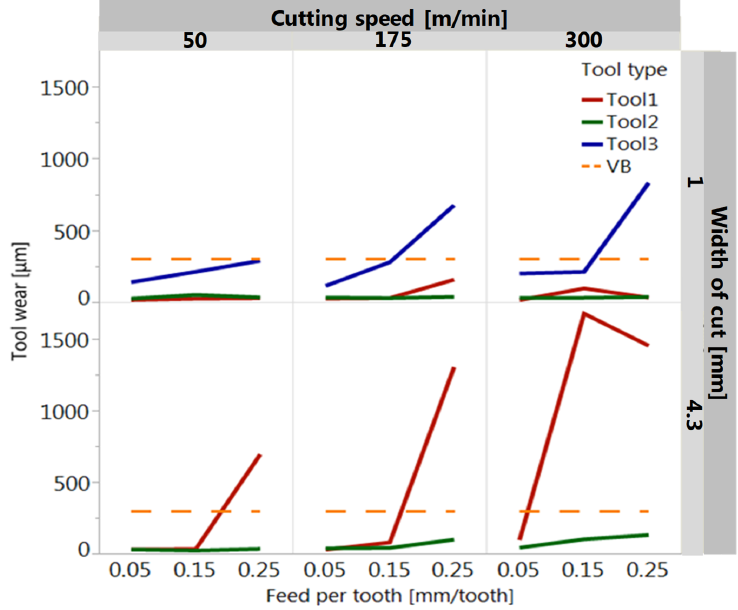
Figure 23. Tool wear effect on each cutter using the different cutting parameters.